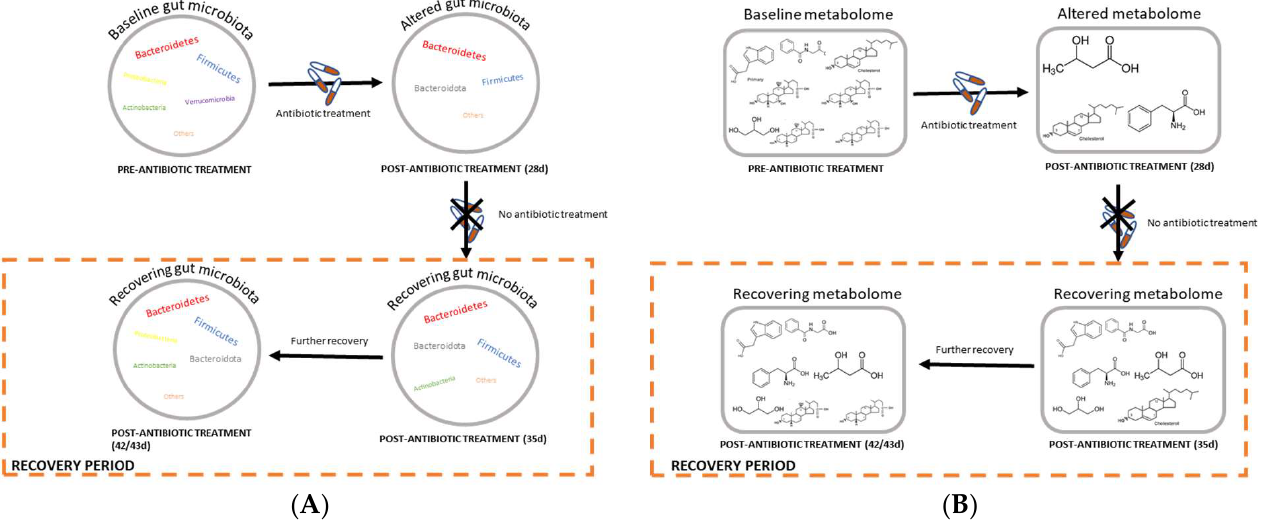
Figure 10. Schematic diagrams of the recovery processes of ( A ) gut or fecal microbiota and ( B ) plasma and feces metabolomes before and after doripenem antibiotic treatments. Baseline state indicates the original or ‘normal’ state of the gut microbiota or metabolomes prior to antibiotic administration, which becomes altered upon 28 days of antibiotic administration. Further, post-antibiotic treatment, a recovery or overcompensation takes place where the gut bacteria as well as the host metabolomes try to return to the ‘normal’